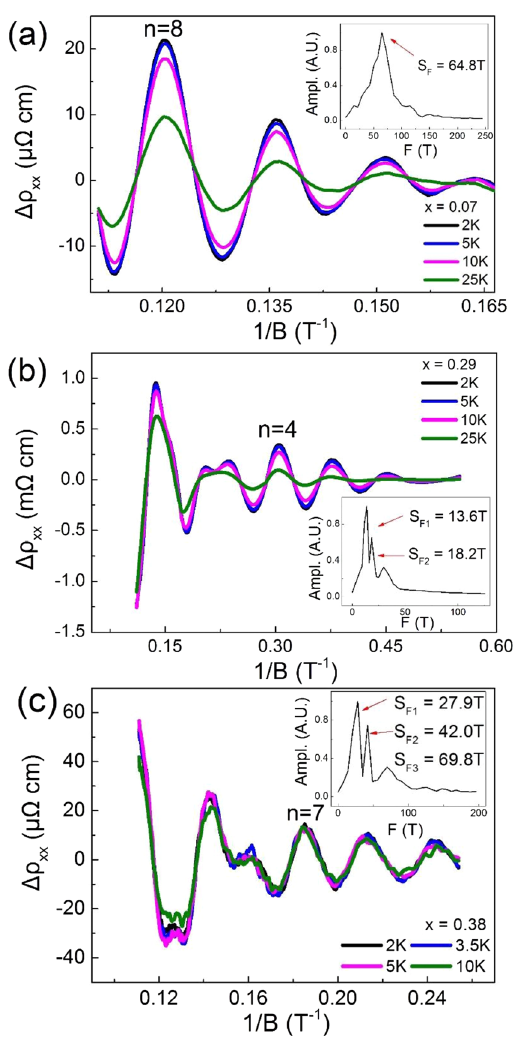
Figure 5. The oscillatory components of Δ ρ xx versus the reciprocal of the magnetic field (1/B) at different temperatures for x = 0.07, 0.29 and 0.38. Insets: Fast Fourier Transform (FFT) spectra for x = 0.07, 0.29 and 0.38. The results of the SdH oscillations are summarized in Table